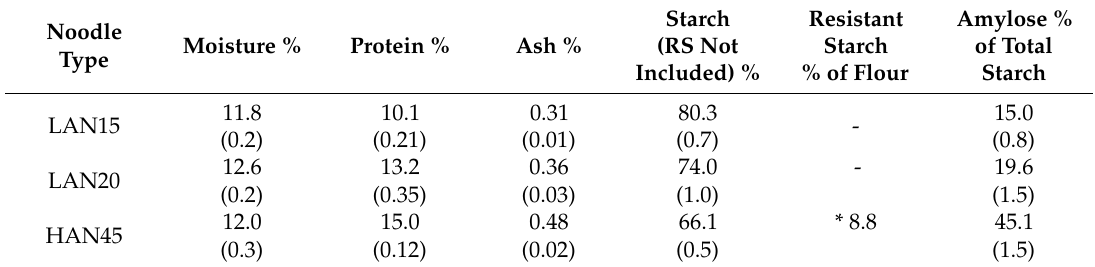
Table 1. Wheat flour composition (P1)